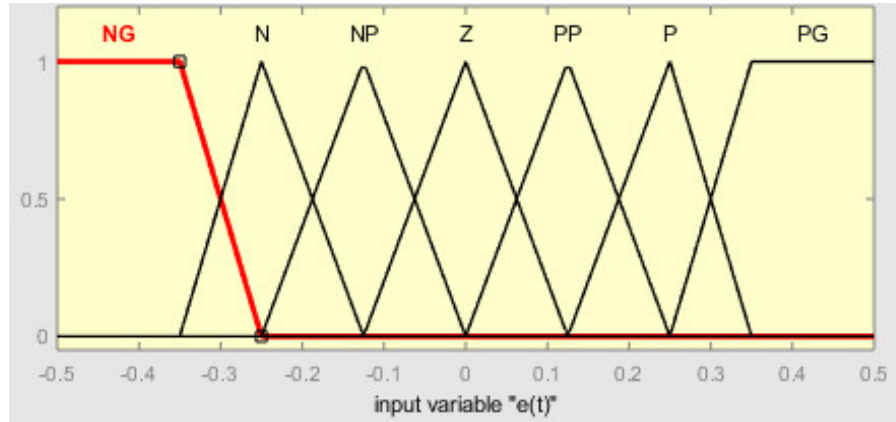
Figure 13. Membership functions and universe of discourse of the error input signal.